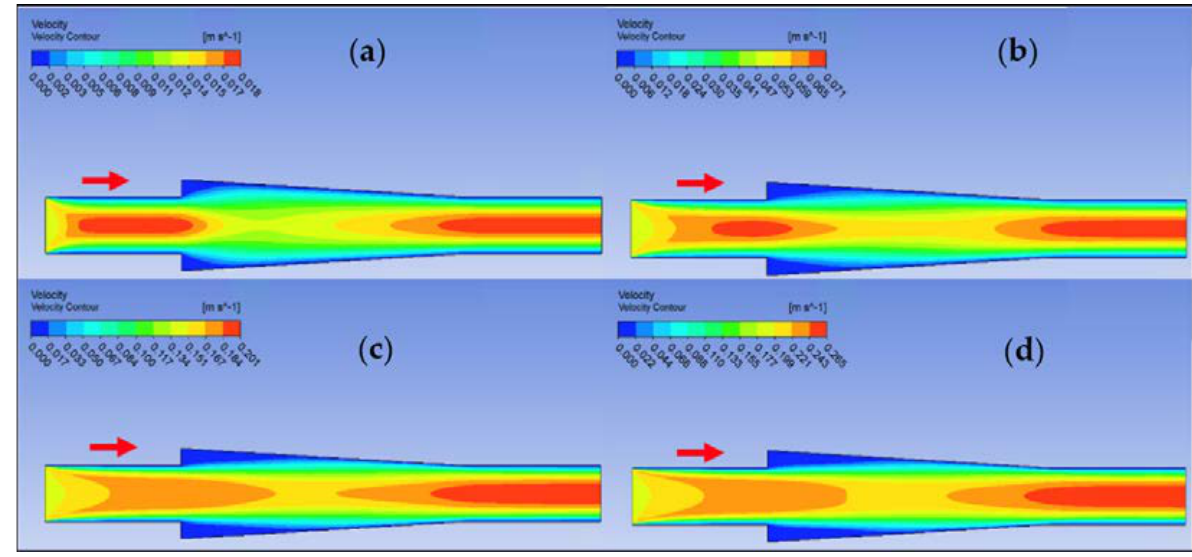
Figure 18. Velocity contour for deionized water in converging connector. ( a ) Re = 25, ( b ) Re = 100, ( c ) Re = 300, and ( d ) Re = 400.